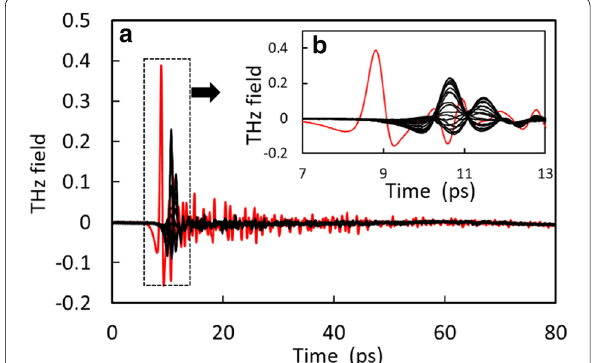
Fig. 1 a Reference (red line) and measured THz wave forms passing through the 2.76-mm-thick oven-dry sample of Japanese cypress.